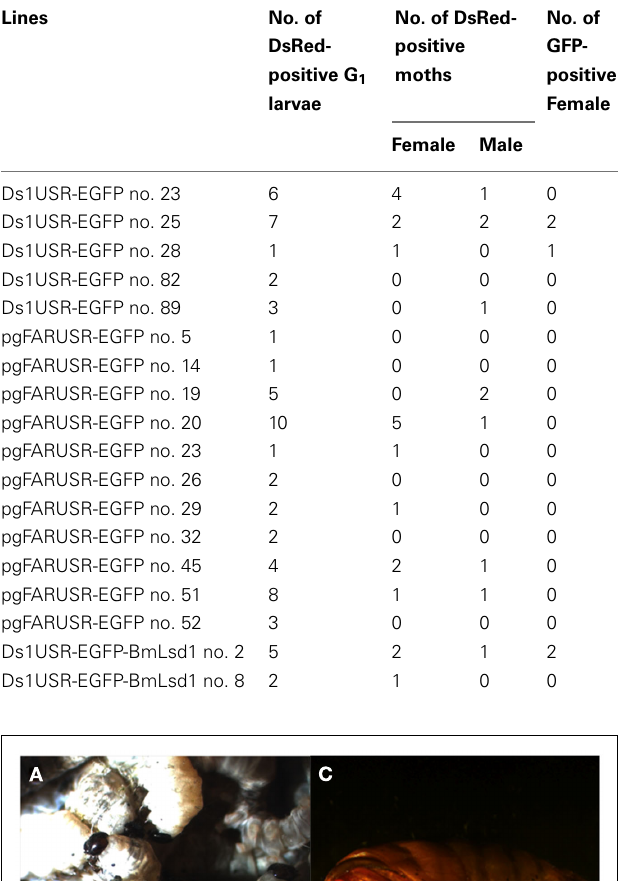
Table 4 | Number of G 1 GFP-positive adults.